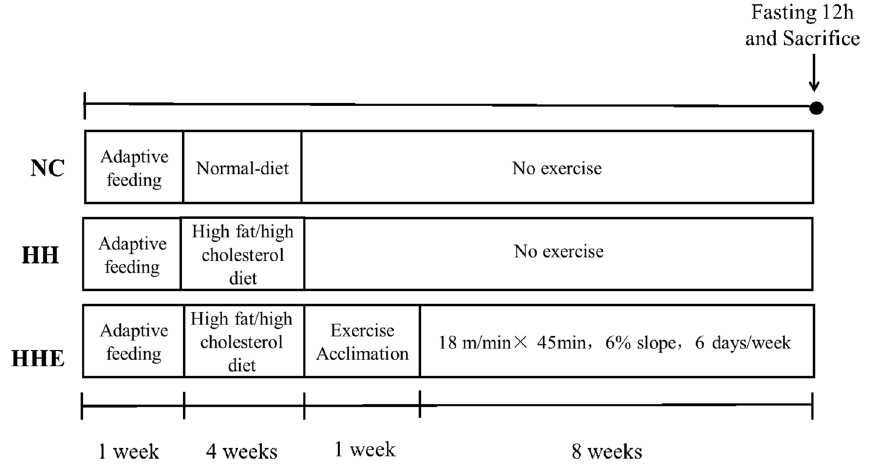
Figure 1. Design of the